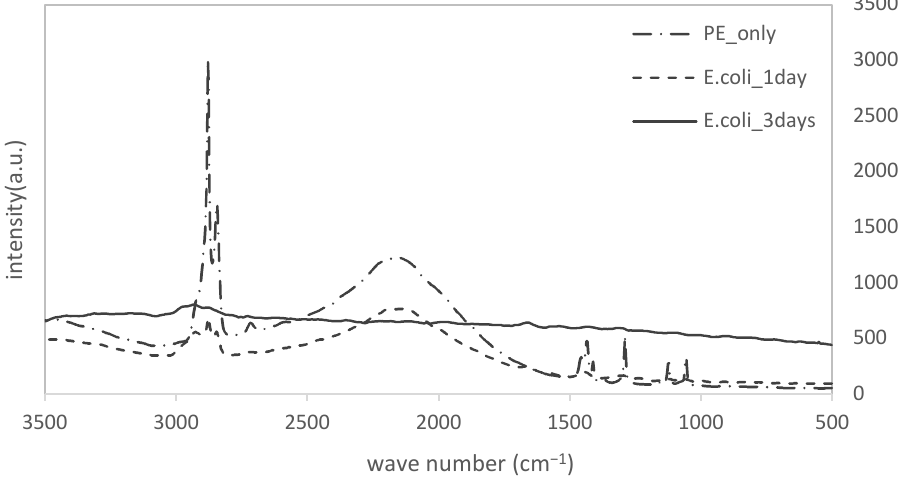
Figure 3. Raman shifts of PE specimens with immersion time.